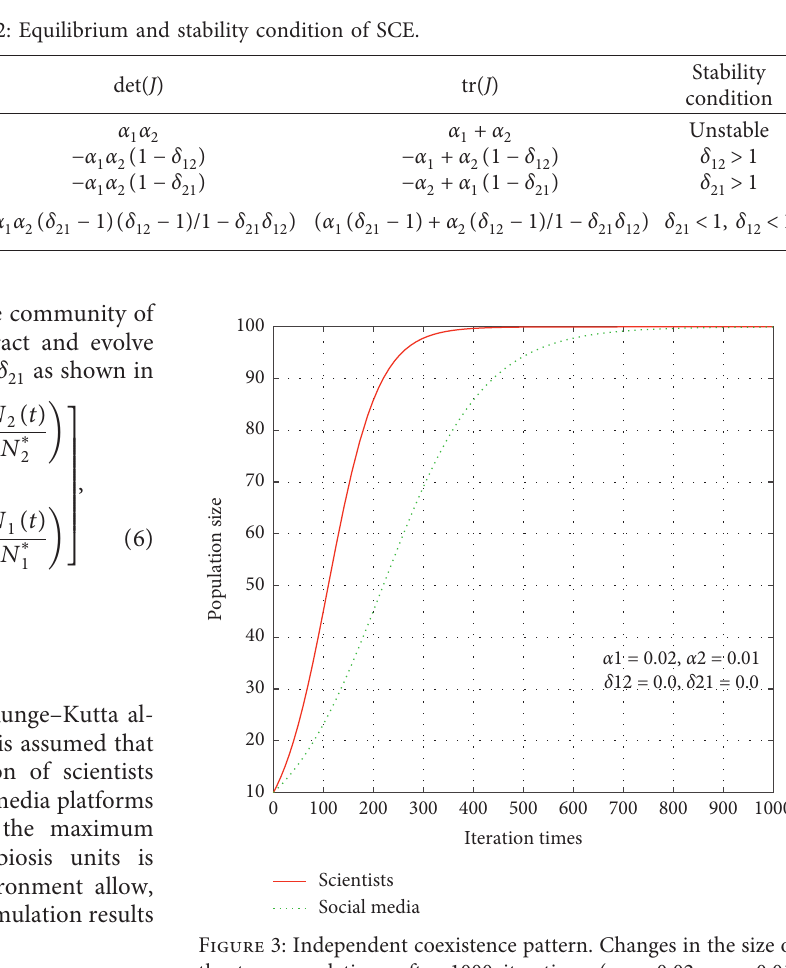
� 0 . 02, α � 0 . 01, 1 2